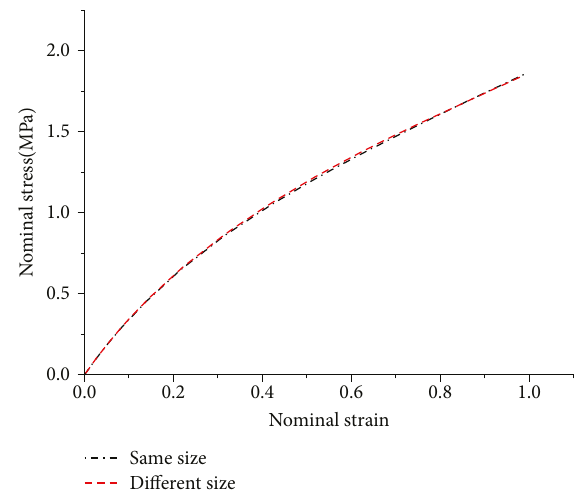
Figure 12: Nominal stress-strain curves for two kinds of RVE